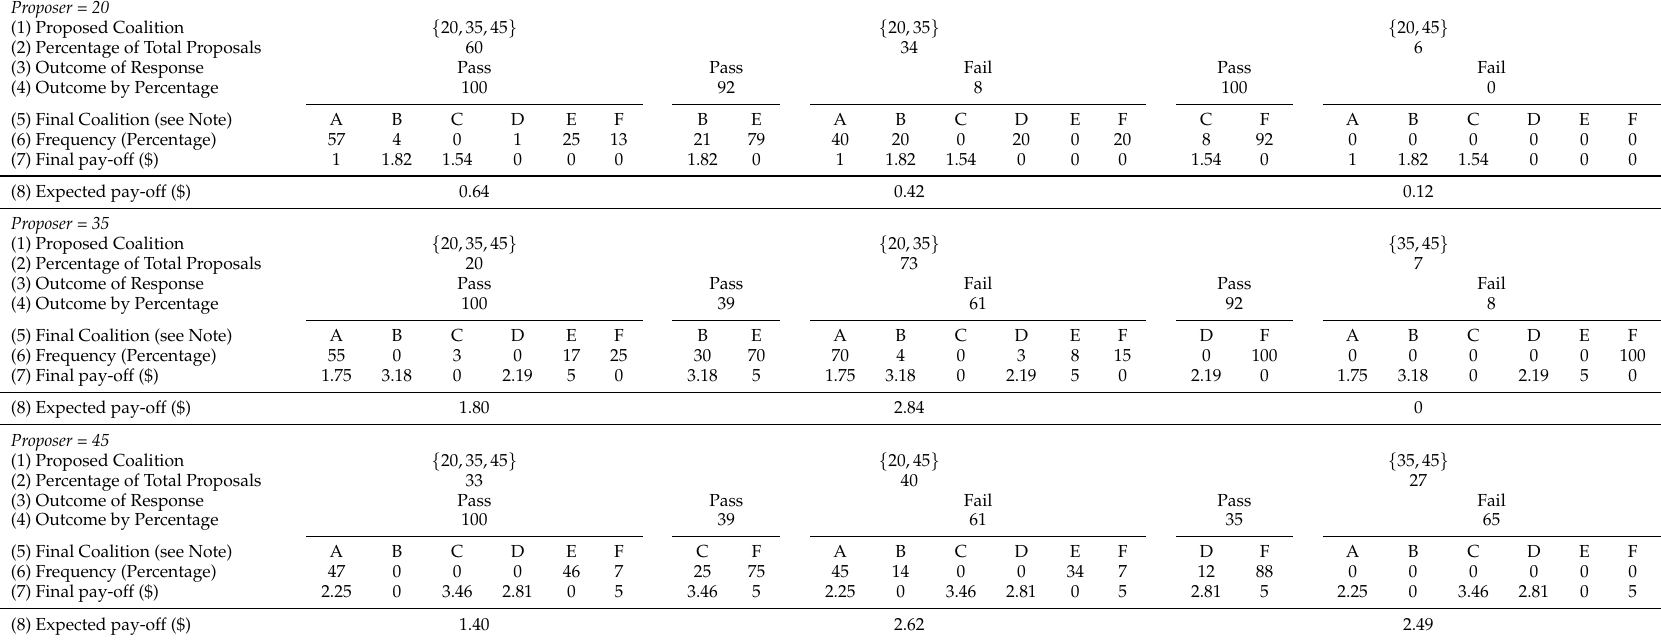
Table A1. Expected payoffs by proposal strategy for each power draw, all